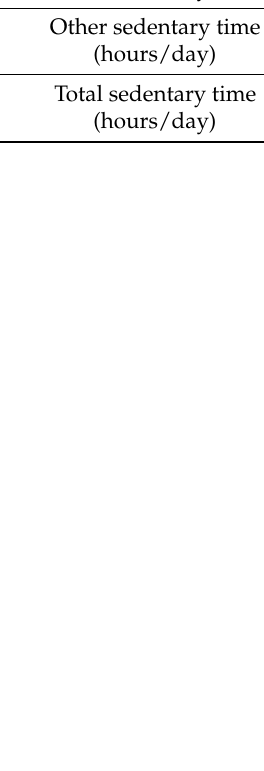
Table 4. Logistic regression analysis to level of GAD-7 based on sedentary time for learning.